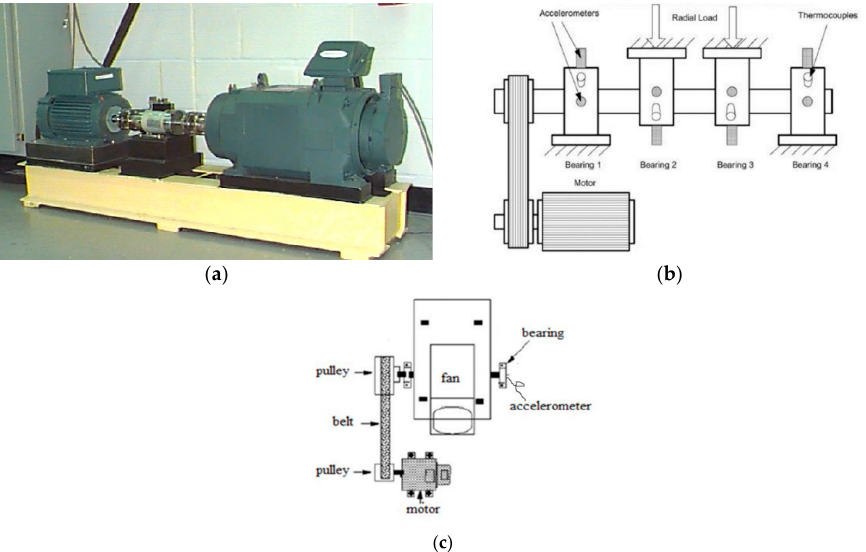
Figure 2. Test rig used in this paper. ( a ) testbed of Case Western Reserve University; ( b ) IMS testbed; ( c ) testbed of JiangNan University. Table 1. Characteristics of bearings in three datasets.